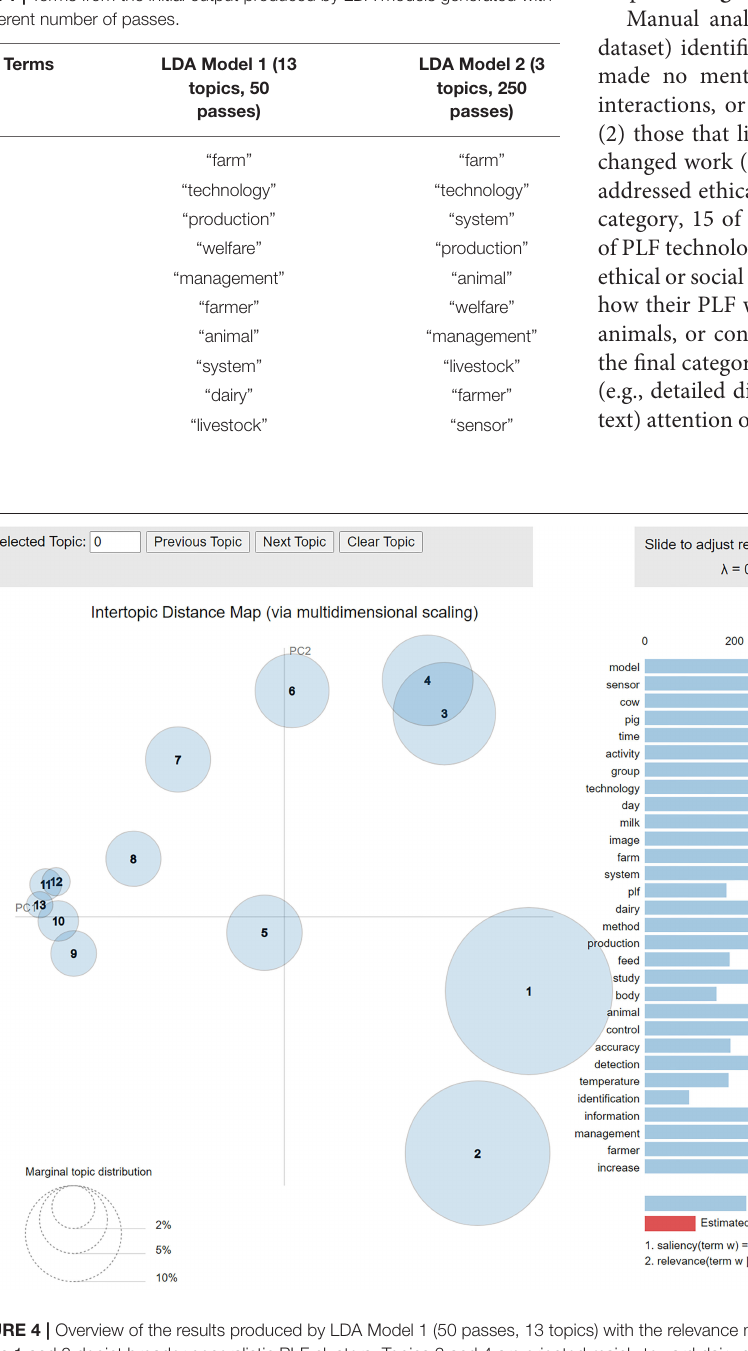
Frontiers in Animal Science |